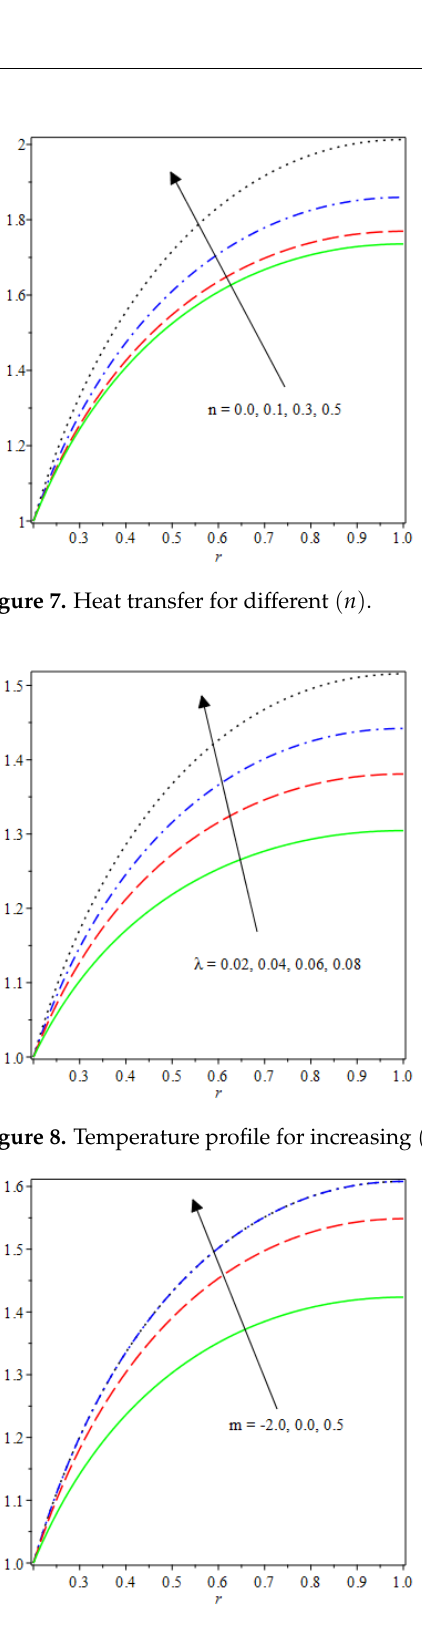
Figure 9. Heat transfer for different ( m )